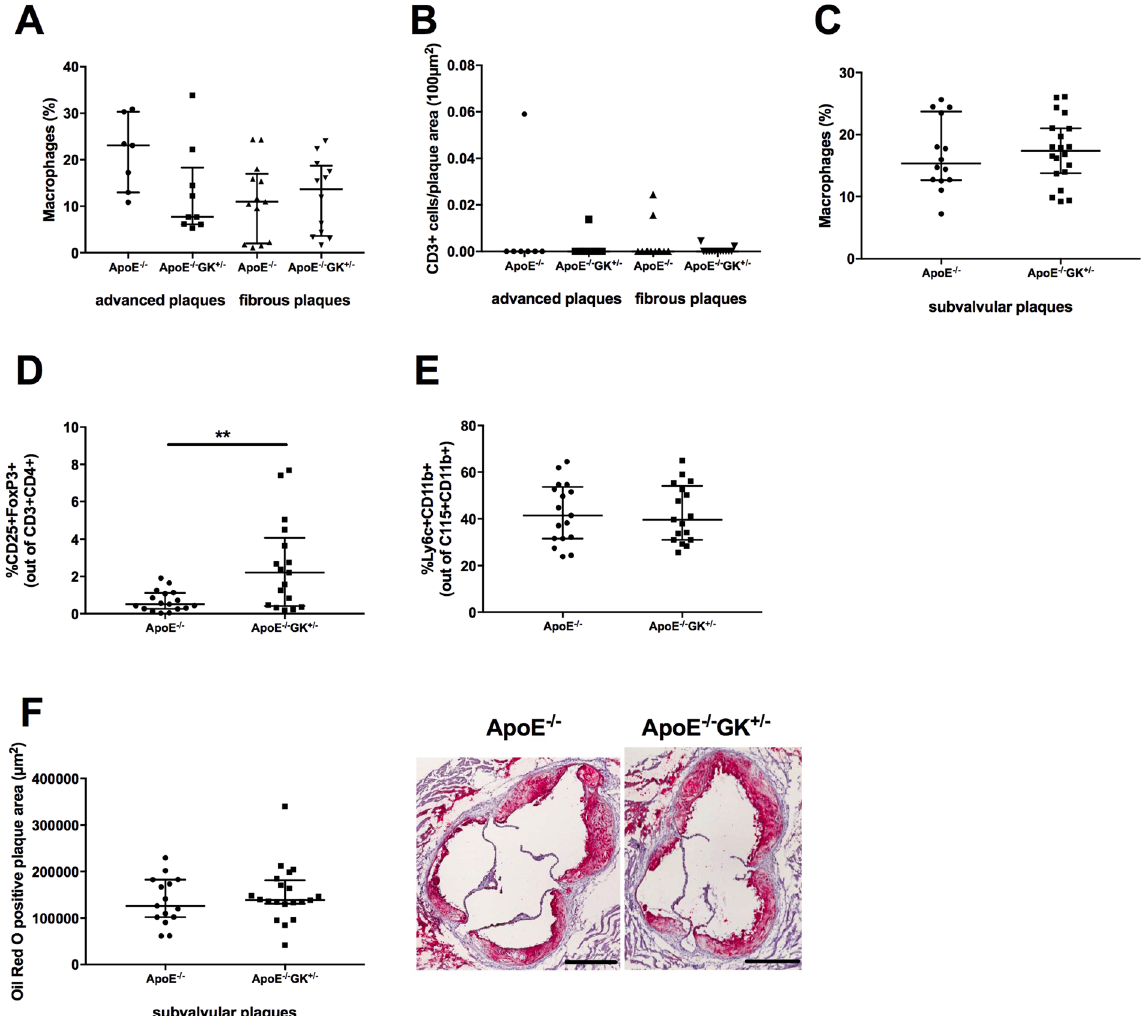
Figure 6. Inflammation is not affected by hyperglycemic conditions in ApoE − / − GK + / − mice. No difference could be found in Mac-2 positive macrophage content in the carotid artery plaques ( A ) or in the subvalvular plaques ( C ). The amount of CD3 positive T-cells in plaques was also similar between the ApoE − / − GK + / − mice and controls ( B ). Increased amount of regulatory T-cells in blood could be observed ( D ), whereas no difference in monocytes could be found ( E ). Subvalvular plaques stained with Oil Red O showing no difference in lipid content between the two groups. Scale bars = 400 µ m ( F ). ** p <